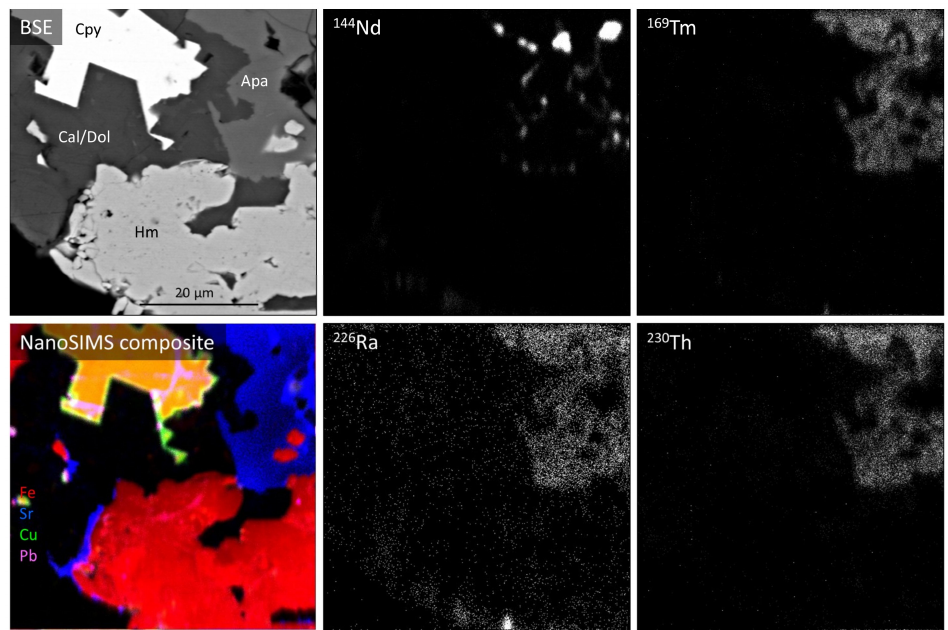
Figure 5. The BSE (top left) and nanoSIMS images of sample 10FC68 comprising an assemblage of apatite, calcite / dolomite (Cal / Dol), chalcopyrite, and hematite (Hm). The composite image represents overlapping nanoSIMS maps of Fe (red), Sr (blue), and Cu (green). Note that orange is the result of a red and green overlap (chalcopyrite in this sample). Rare earth elements (represented by 144 Nd and 169 Tm), Ra, and Th are found throughout the apatite (and only the apatite), though no zoning is evident.